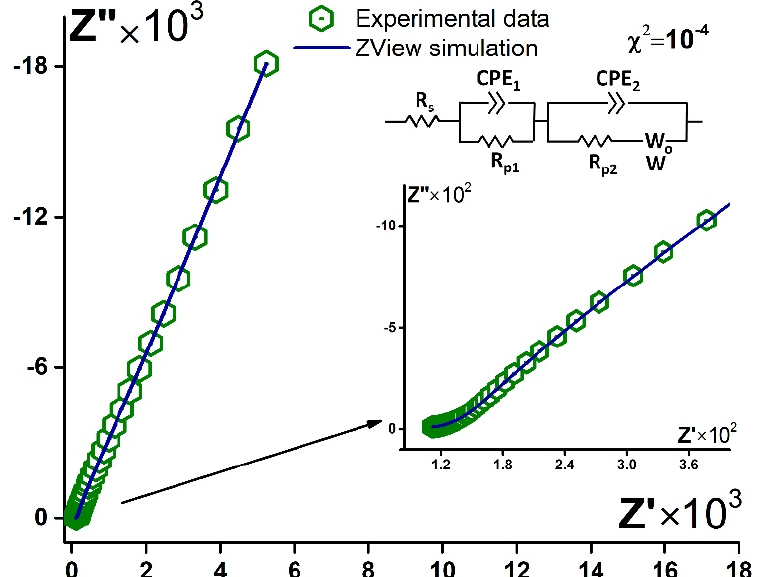
Figure 9. Typical experimental data (green hexagons) and simulated Nyquist plot (blue curve) for aptasensor (Au disc/LC-18) before/after contact with blood plasma. Solution: PBS (7.4). Inset: equivalent circuit.